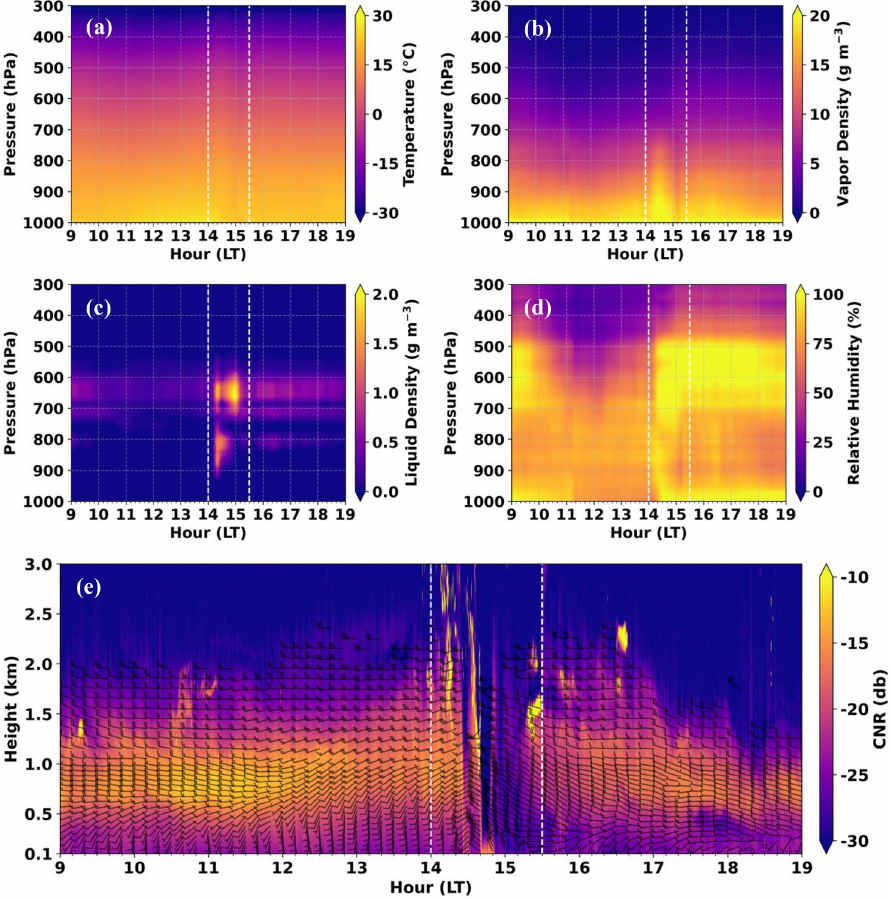
Figure 12. The MWR-measured time–height cross section plots for (a) temperature ( ◦ C), (b) vapor density (gm − 3 ), (c) liquid density (gm − 3 ), (d) relative humidity (%), and (e) DL-measured CNR (dB) with 10min averaged wind barbs at Albany on 12 August 2021. Dotted box represents thunderstorm